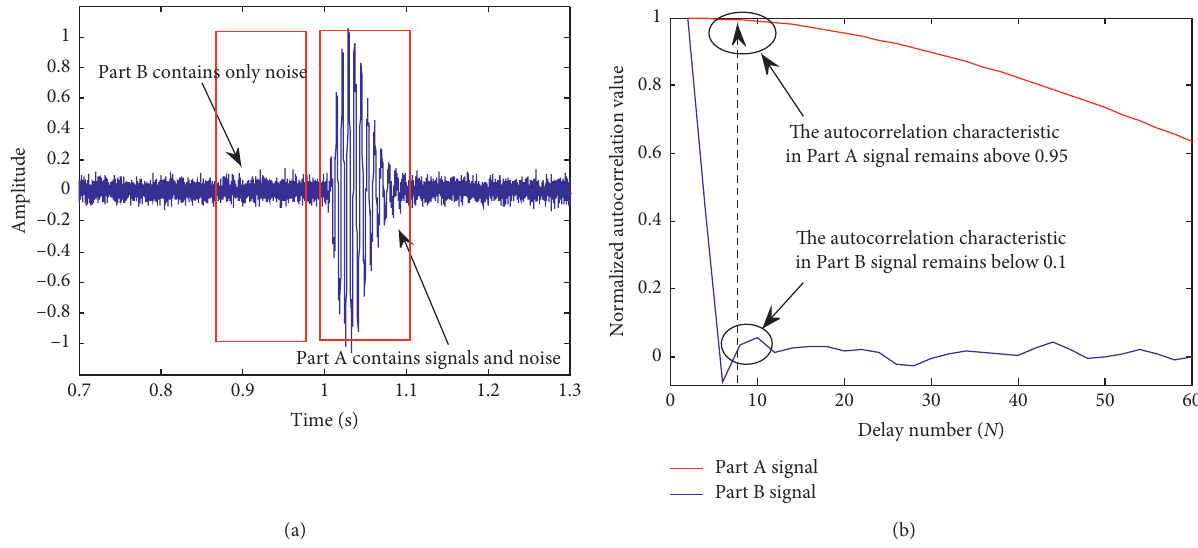
Figure 5: Autocorrelation results of signal and noise, respectively. (a) Underground explosion vibration signal. (b) Autocorrelation characteristic curves of 2 kinds of